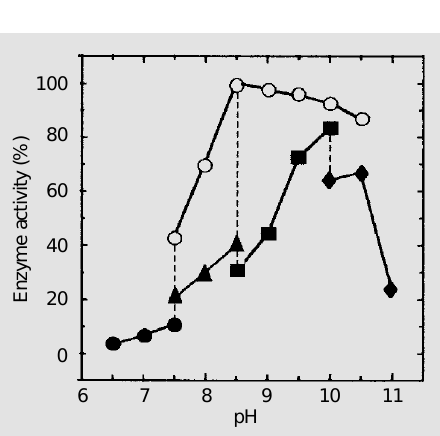
Figure 5 - pH activity profile of purified constitutive alkaline phosphatase synthesized by strain 74A of N. crassa grown in high-Pi medium at 30 o C, pH 7.1. Filled circles, triangles, squares and lozenges represent the en- zyme activity in the presence of 0.3 M PIPES buffer, pH 6.5-7.5, 0.3 M TAPS buffer, pH 7.5-8.5, 0.3 M CHES buffer, pH 8.5-10.0, and 0.3 M CAPES buffer, pH 10.0-11.0, respectively. Open circles represent the enzyme ac- tivity in the presence of the mix- ture containing the proper buffer and 0.3 M Tris-HCl, pH 7.5-10.5. For details, see Material and Methods.